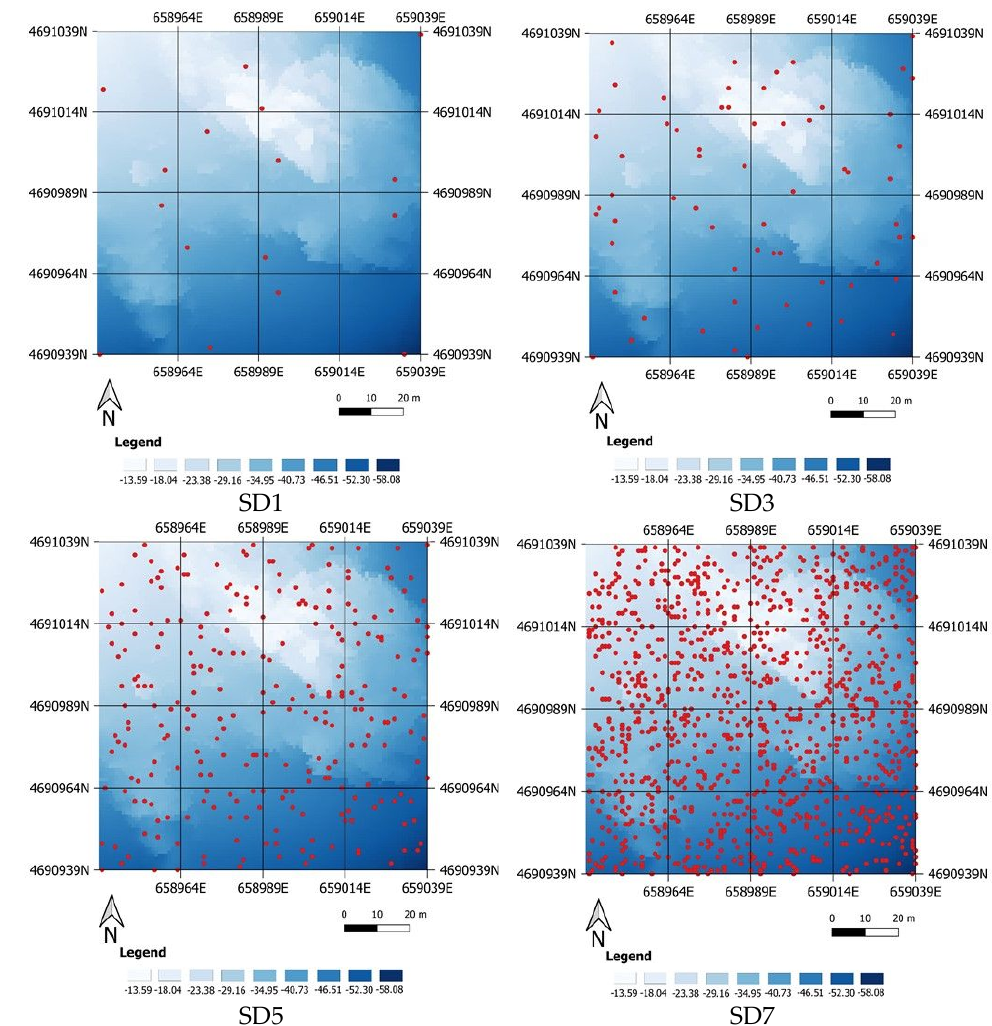
Figure 4. Representation of four sampling densities (SD1, SD3, SD5 and SD7) extracted from the entire initial dataset for the sector Q4. It corresponds to one of the four sample point repetitions.